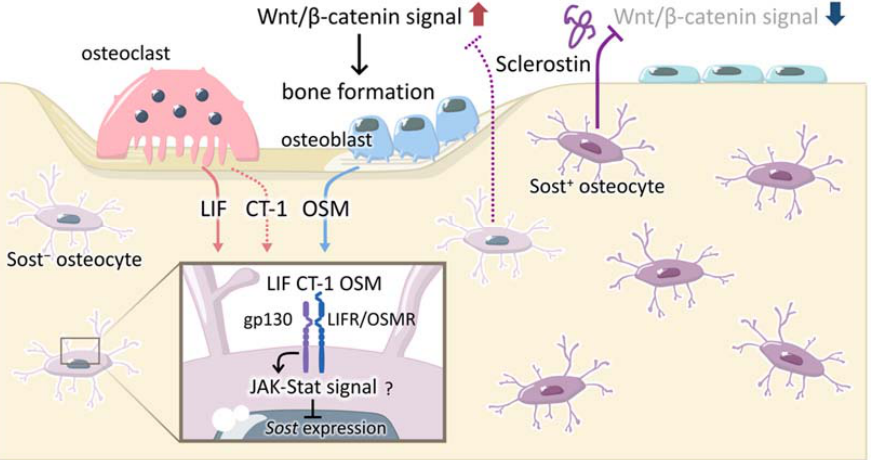
Figure 2. Roles of LIF, CT ‐ 1, and OSM in bone remodeling. Osteoclast ‐ derived LIF, CT ‐ 1, and osteoblast ‐ derived OSM inhibit the expression of sclerostin in osteocytes. These cytokines bind to gp130 and LIFR/OSMR, and may inhibit Sost expression via the JAK ‐ Stat signal. The inhibition of sclerostin expression enhances Wnt/ β‐ catenin signals in osteoblasts, which, in turn, promote bone formation. LIF, leukemia inhibitory factor; CT ‐ 1, cardiotropin ‐ 1; OSM, oncostatin M; LIFR, LIF receptor; OSMR, OSM receptor; JAK ‐ Stat, janus kinase ‐ signal transducer and activator of transcription. To clearly observe cells expressing sclerostin, Sost Green/+ mice, in which a part of exon 1 after the Sost start codon was replaced with ZsGreen cDNA (coding green fluorescent